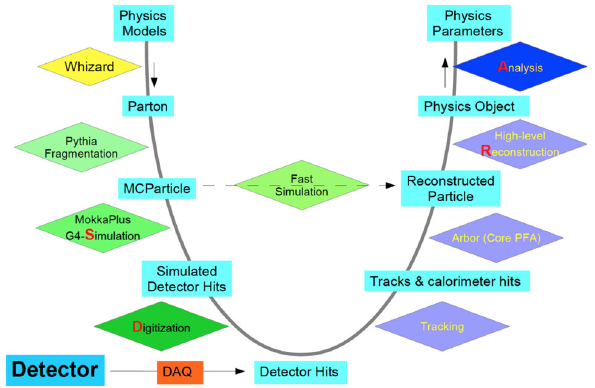
Fig. 3 The information flow of the CEPC software chain